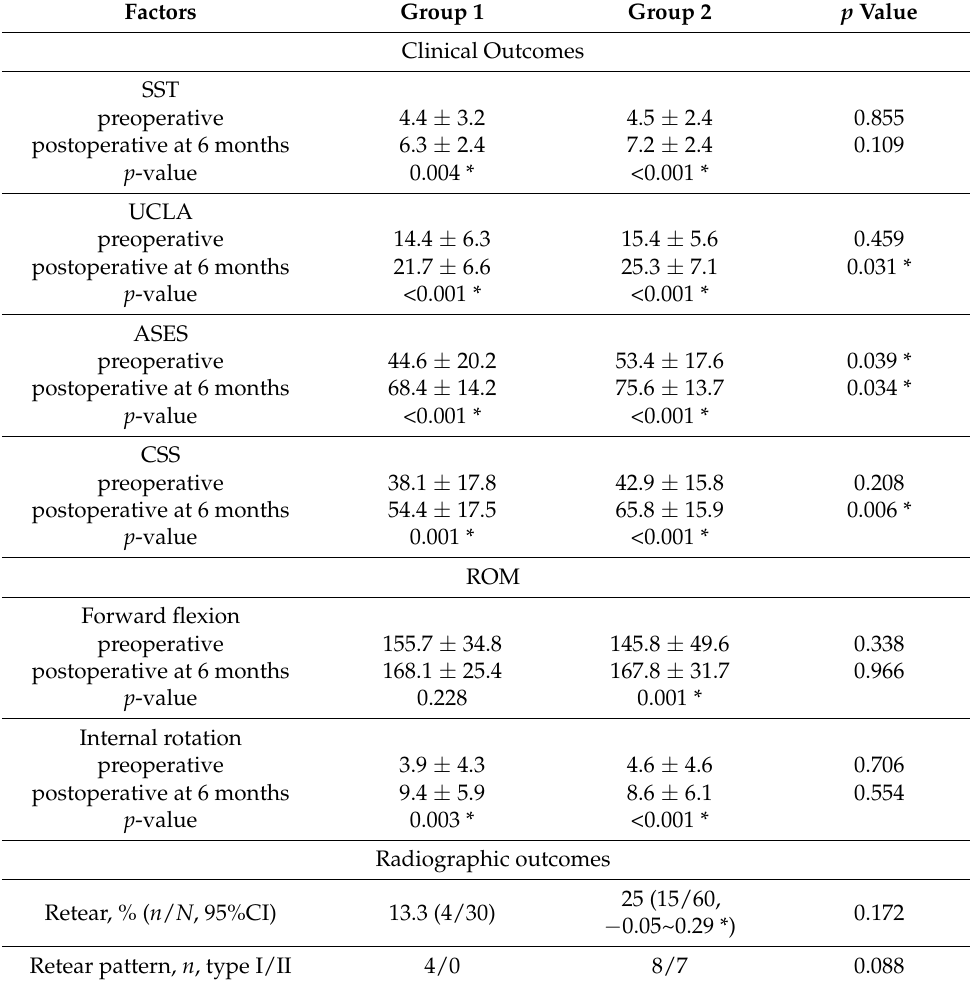
Table 2. Comparison of clinical and radiographic outcomes between Groups 1 and